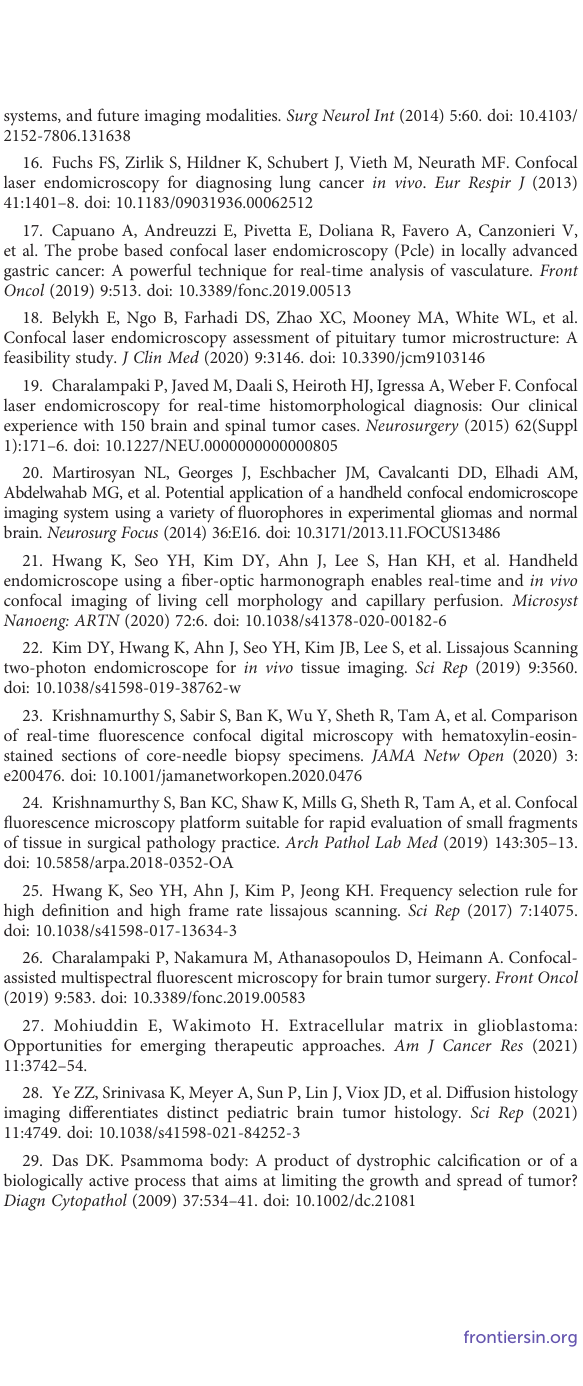
SUPPLEMENTARY VIDEO 3 Real-time examination of the meningothelial meningioma tissue from resected human specimen. The H&E stained, and CLE scanned images from the same tissue were presented in Figure 5B and Supplementary Figure